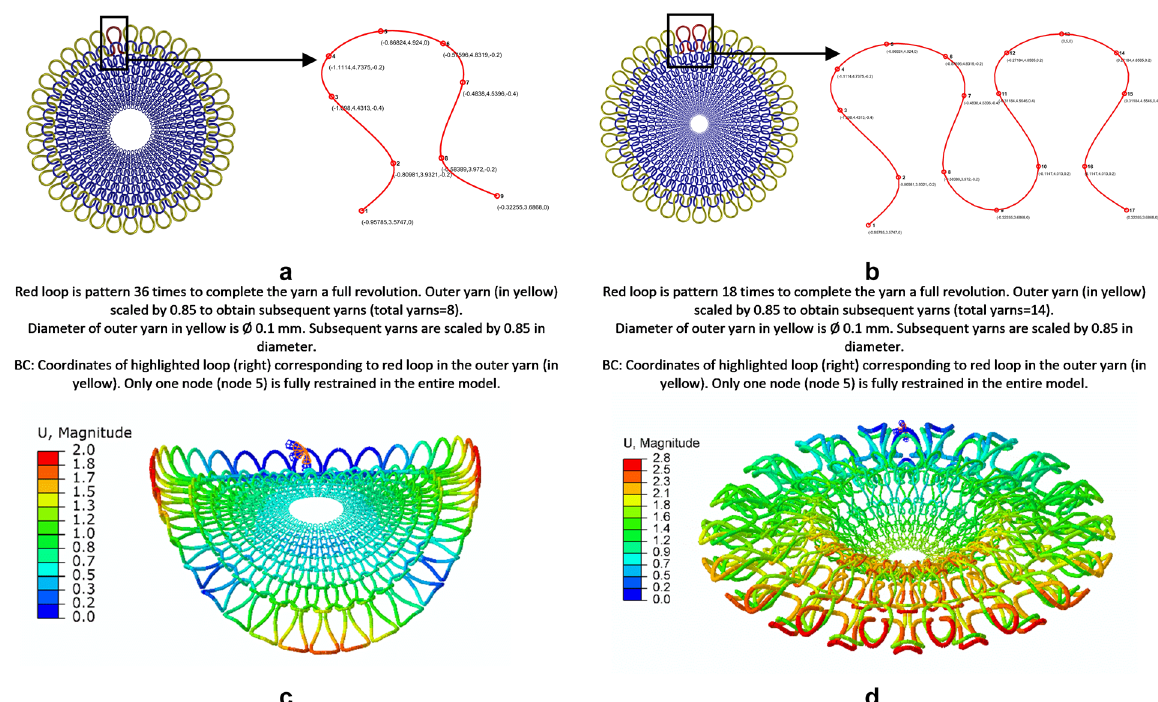
Figure 3. Basic architecture-based morphing. ( a ) Material properties defined use the color coding for the plain and rib knit. ( b ) Blue represents negative thermal coefficient of expansion whereas red represents positive thermal coefficient of expansion. ( c ) Geometric properties of the a single loop highlighted in red, which is then patterned. ( d ) Geometric properties of the a single loop highlighted in red, which is then patterned. ( e ) A plain knit morphs into a concave saddle shape. ( f ) A rib knit morphs into axi-symmetric cup